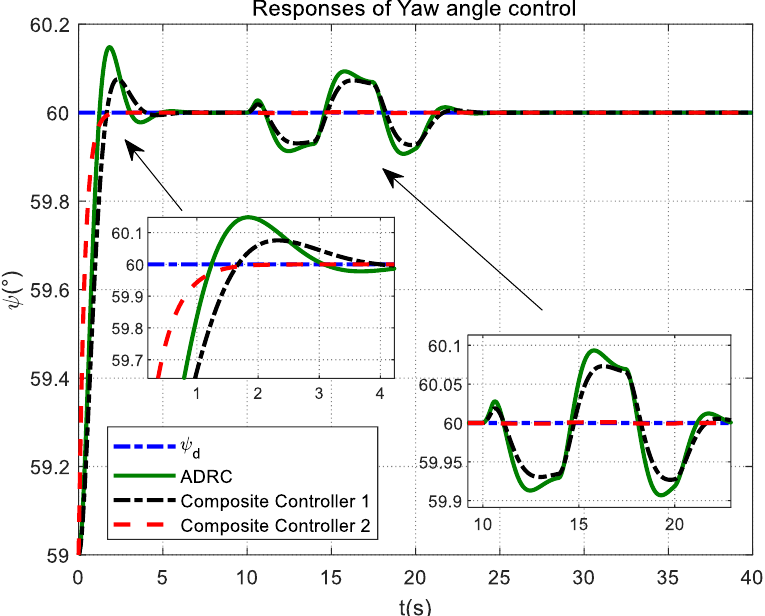
Figure 11. Responses of Yaw angle control for QUAV under actuator constant fault and disturbance condition.